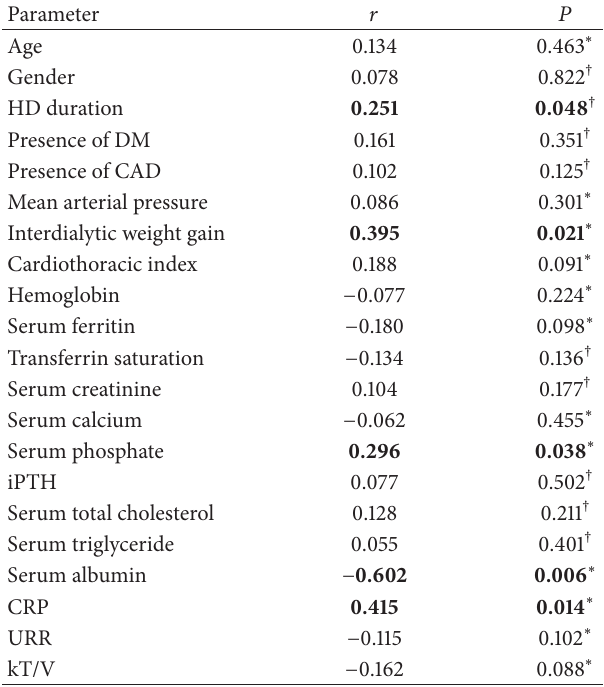
Table 3: Bivariate correlation analyses of RDW levels and various clinical and laboratory parameters of study population.